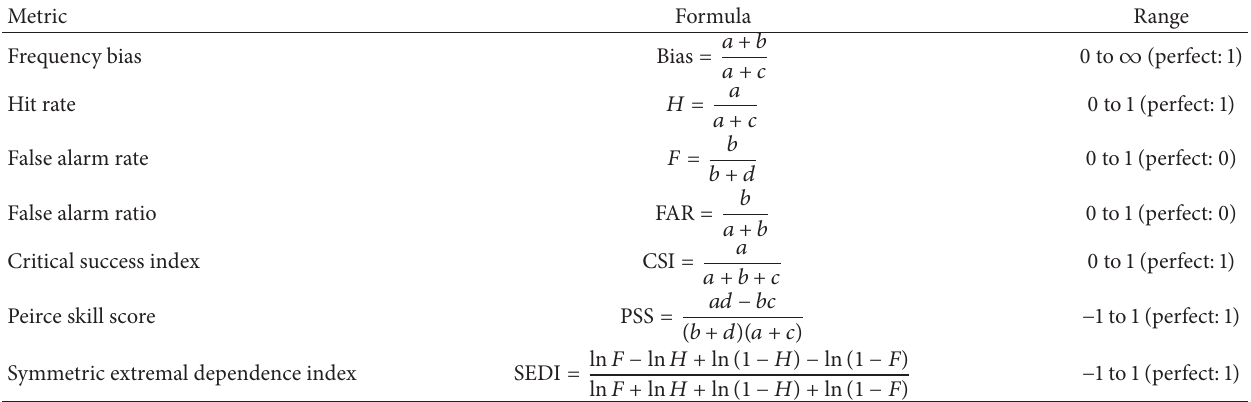
Table 2: Categorical measures used in this study along with their definitions based on a binary truth table, where 𝑎 is the number of events which were forecast correctly, 𝑐 the number of observed events not forecast, 𝑏 the number of nonevents incorrectly forecast, and 𝑑 the number of nonevents correctly